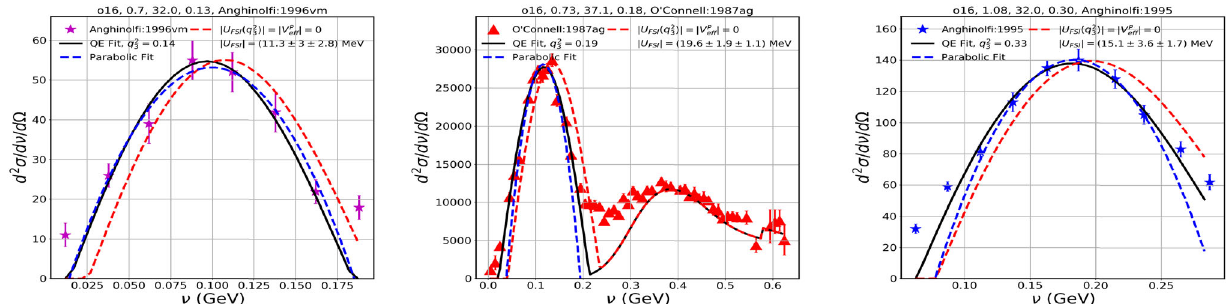
Fig. 10 Same as Fig. 8 for three out of four 16